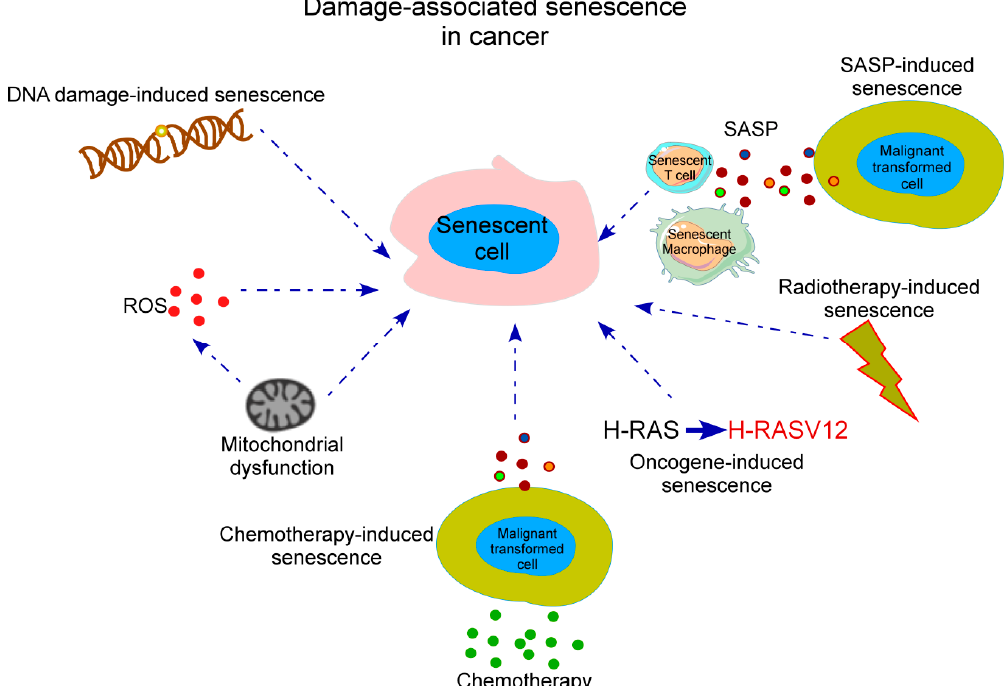
Figure 1 . Stress-mediated inducers of cellular senescence in cancer. Damage-associated senescence associated with cancer development can occur in cells of the immune system due to SASP released by tumorcells, afteraccumulationofDNAdamage, afterinflammatoryinsultssuchasROSormitochondrial dysfunction which also impacts ROS production, after radiotherapy damage and chemotherapy treatments in tumor cells and also as a result of oncogenic mutations. SASP, senescence-associated secretory phenotype; ROS, reactive oxygen